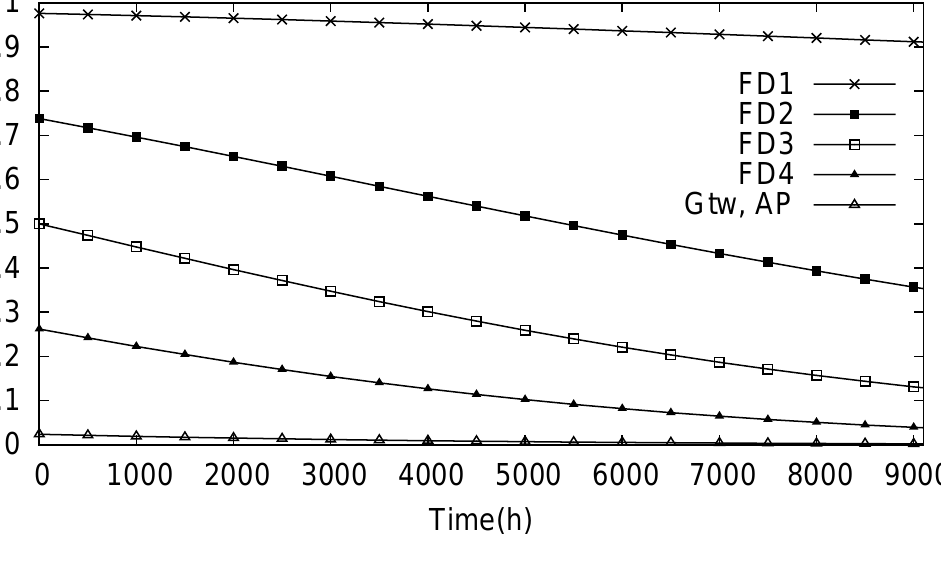
Table 1. Sensitivity